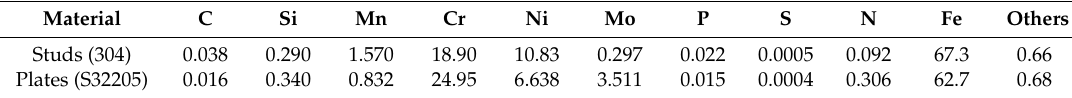
Table 1. Spectral analysis of studs and plates (values by wt. %).